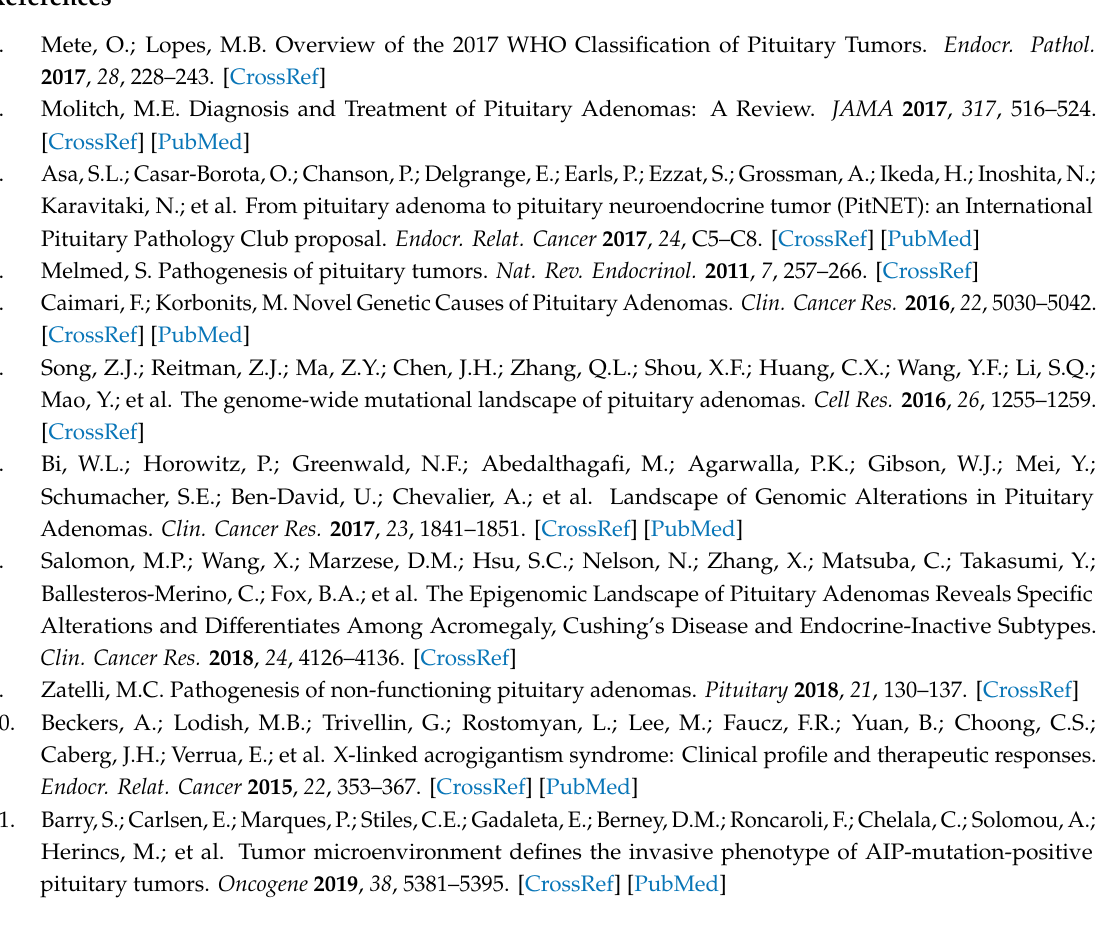
of NFPTs observed in the first heatmap; Figure S4: Somatotropinomas (GHomas). mRNA expression levels of all spliceosome components and splicing factors measured in GHomas compared to NPs using the qPCR array; Figure S5: Corticotropinomas (ACTHomas). mRNA expression levels of all spliceosome components and splicing factors measured in ACTHomas compared to NPs using the qPCR array; Figure S6: Prolactinomas (PRLomas). mRNA expression levels of all spliceosome components and splicing factors measured in PRLomas compared to NPs using the qPCR array; Figure S7: (A) Individual Fold-Change of spliceosome machinery expression levels showing the common dysregulated components (blue and yellow colors) in all PitNETs subtypes compared to NPs. (B) mRNA expression levels of spliceosome components and the splicing factor commonly dysregulated in NFPTs, GHomas, ACTHomas, and PRLomas, respectively; Table S1: Results from Chi-square test of clinical parameters between P1 and P2 of NFPTs derived from the second heatmap; Table S2: Results from Chi-square test of clinical parameters between P1, P2, P3 and P4 of NFPTs derived from the first heatmap (cutting the dendogram at second highest